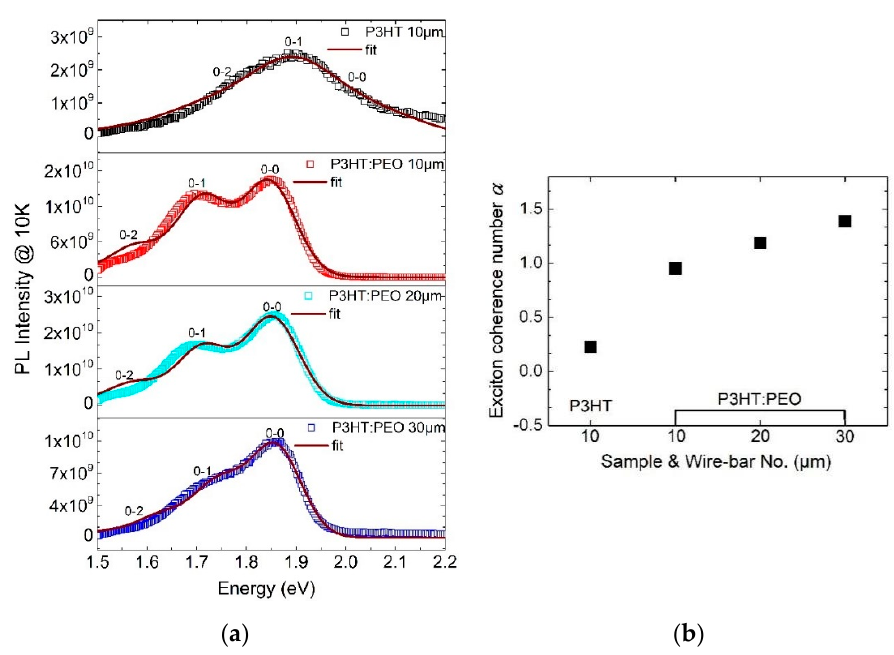
Figure 3. ( a ) PL spectra of poly (3-hexylthiophene-2,5-diyl) (P3HT) and P3HT: poly (ethylene oxide) (PEO) wire-bar-coated film with the excitation at 470 nm. I 0-0 , I 0-1 , I 0-2 vibronic features reflect the transitions from the first excited state to the ground state. ( b ) The intrachain exciton coherence number α of wire-bar-coated films is achieved by simulating PL spectra of films with Equation